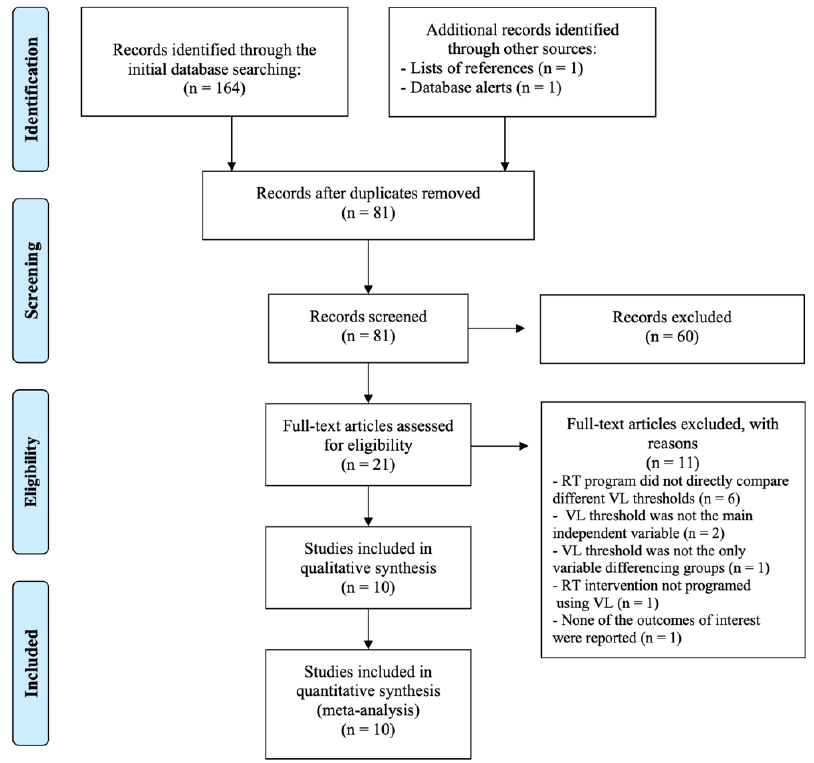
Figure 1. Flowchart illustrating the different phases of the search and study selection. RT: resistance training; VL: velocity loss; n: number.